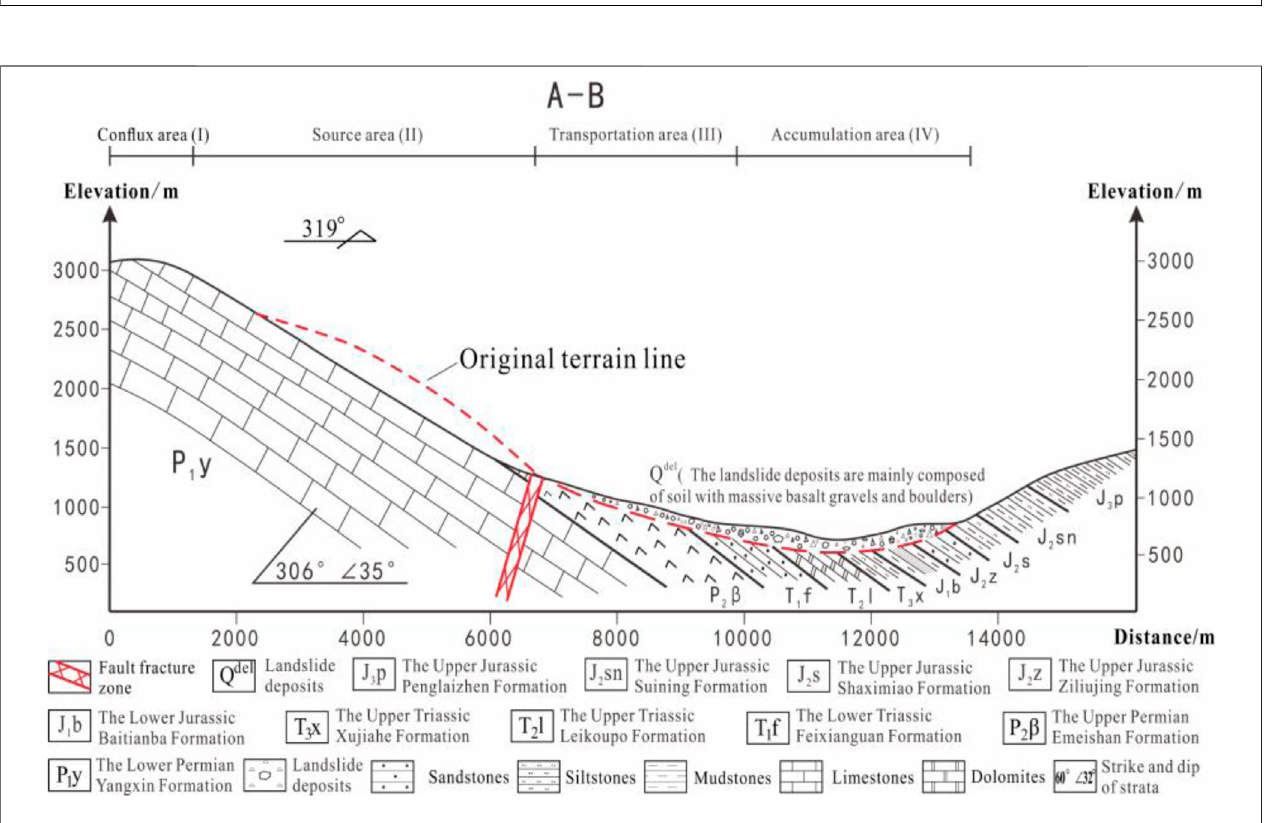
FIGURE 5 | The geological cross section pro fi le of the Jiaopenba